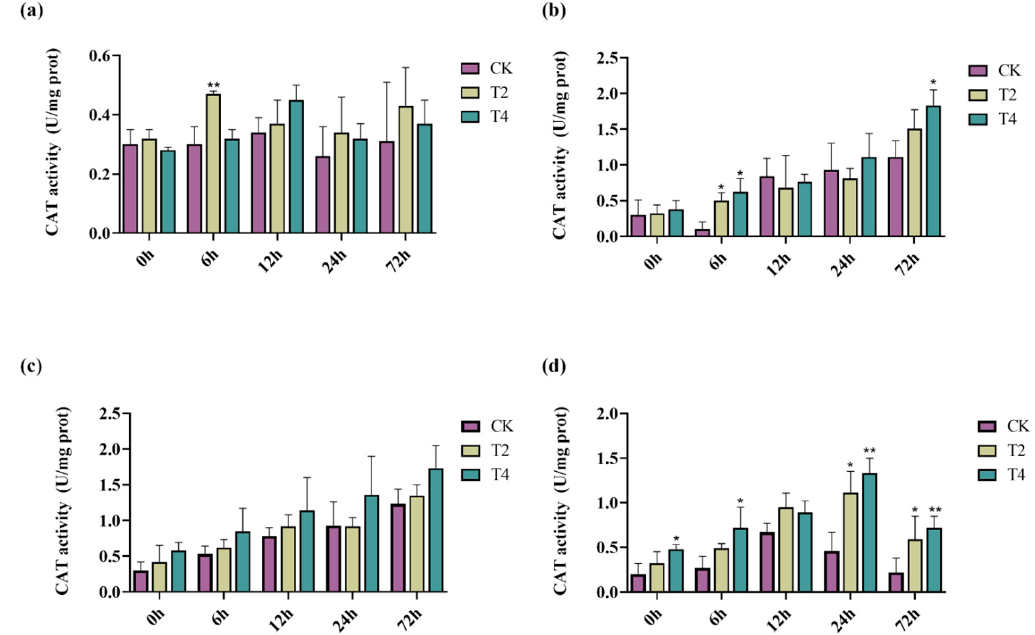
Figure 7. CAT activity of transgenic and non-transgenic poplar plants subjected to different NaCl concentrations. Note: ( a ) without NaCl; ( b ) 100 mM NaCl; ( c ) 200 mM NaCl; and ( d ) 300 mM NaCl (The “*” above the histogram indicates significance. “*” indicates p < 0.05, “**” indicates p <